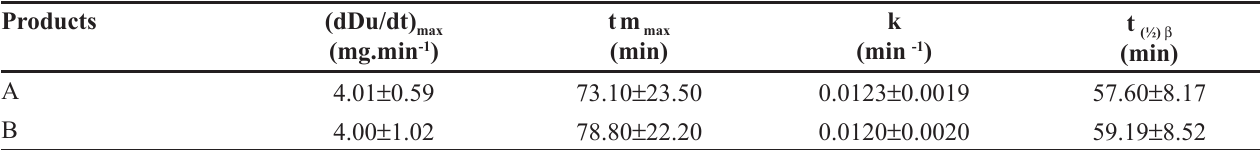
TABLE III - Mean of pharmacokinetics parameters after oral administration of cephalexin (A and B products, n=24). Values represent mean ± standard deviation Products